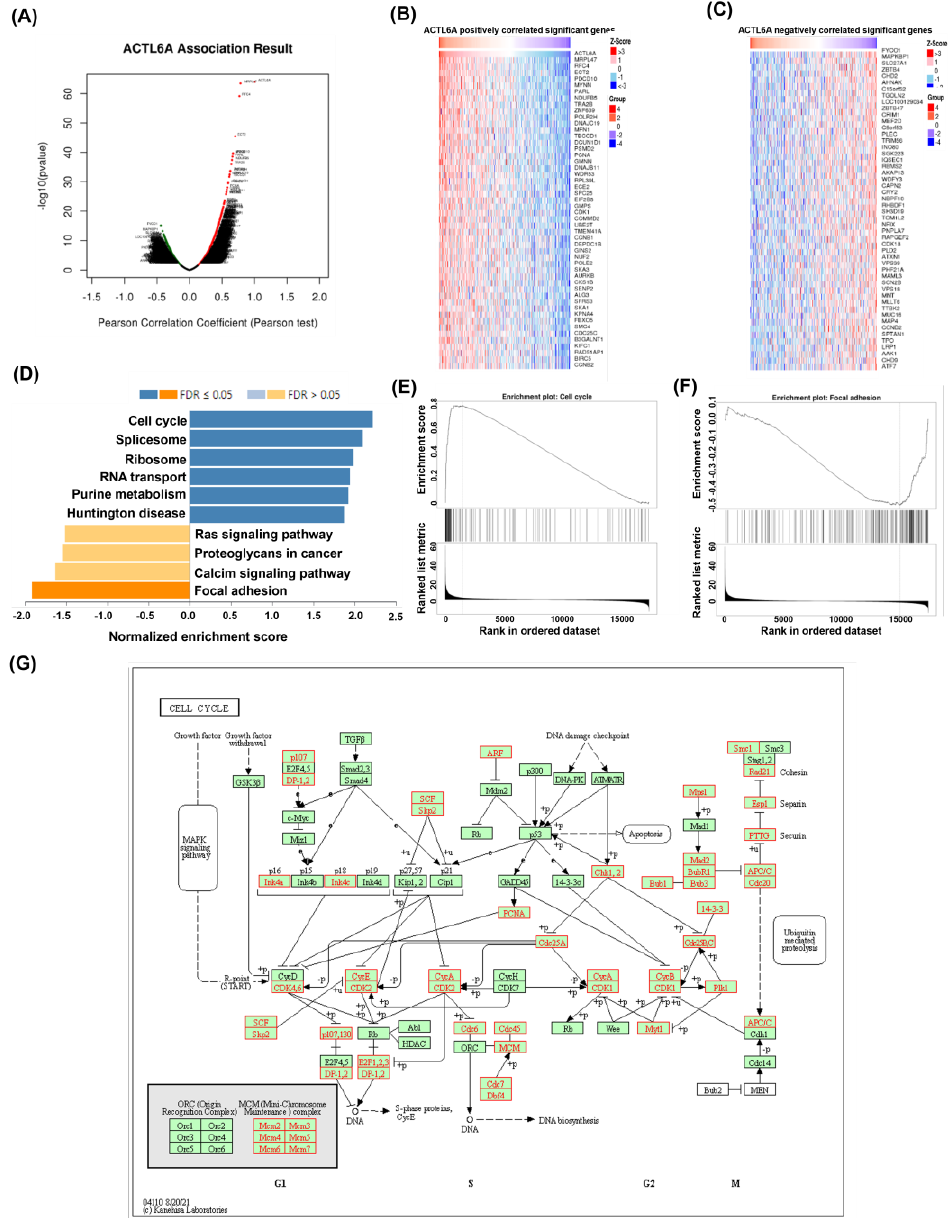
Figure 3. Most cell cycle genes in positive correlation and focal adhesion genes in negative correlation with ACTL6A in ovarian cancer. ( A ) Association results of ACTL6A in ovarian cancer (Number of patients = 303); Pearson test was performed to analyze LinkFinder. Volcano plots show the statistical association results of ACTL6A for all ovarian cancer DEGs. ( B ) Data for the top 50 positive association genes are visualized in a heat map. ( C ) Data for the top 50 negative association genes are